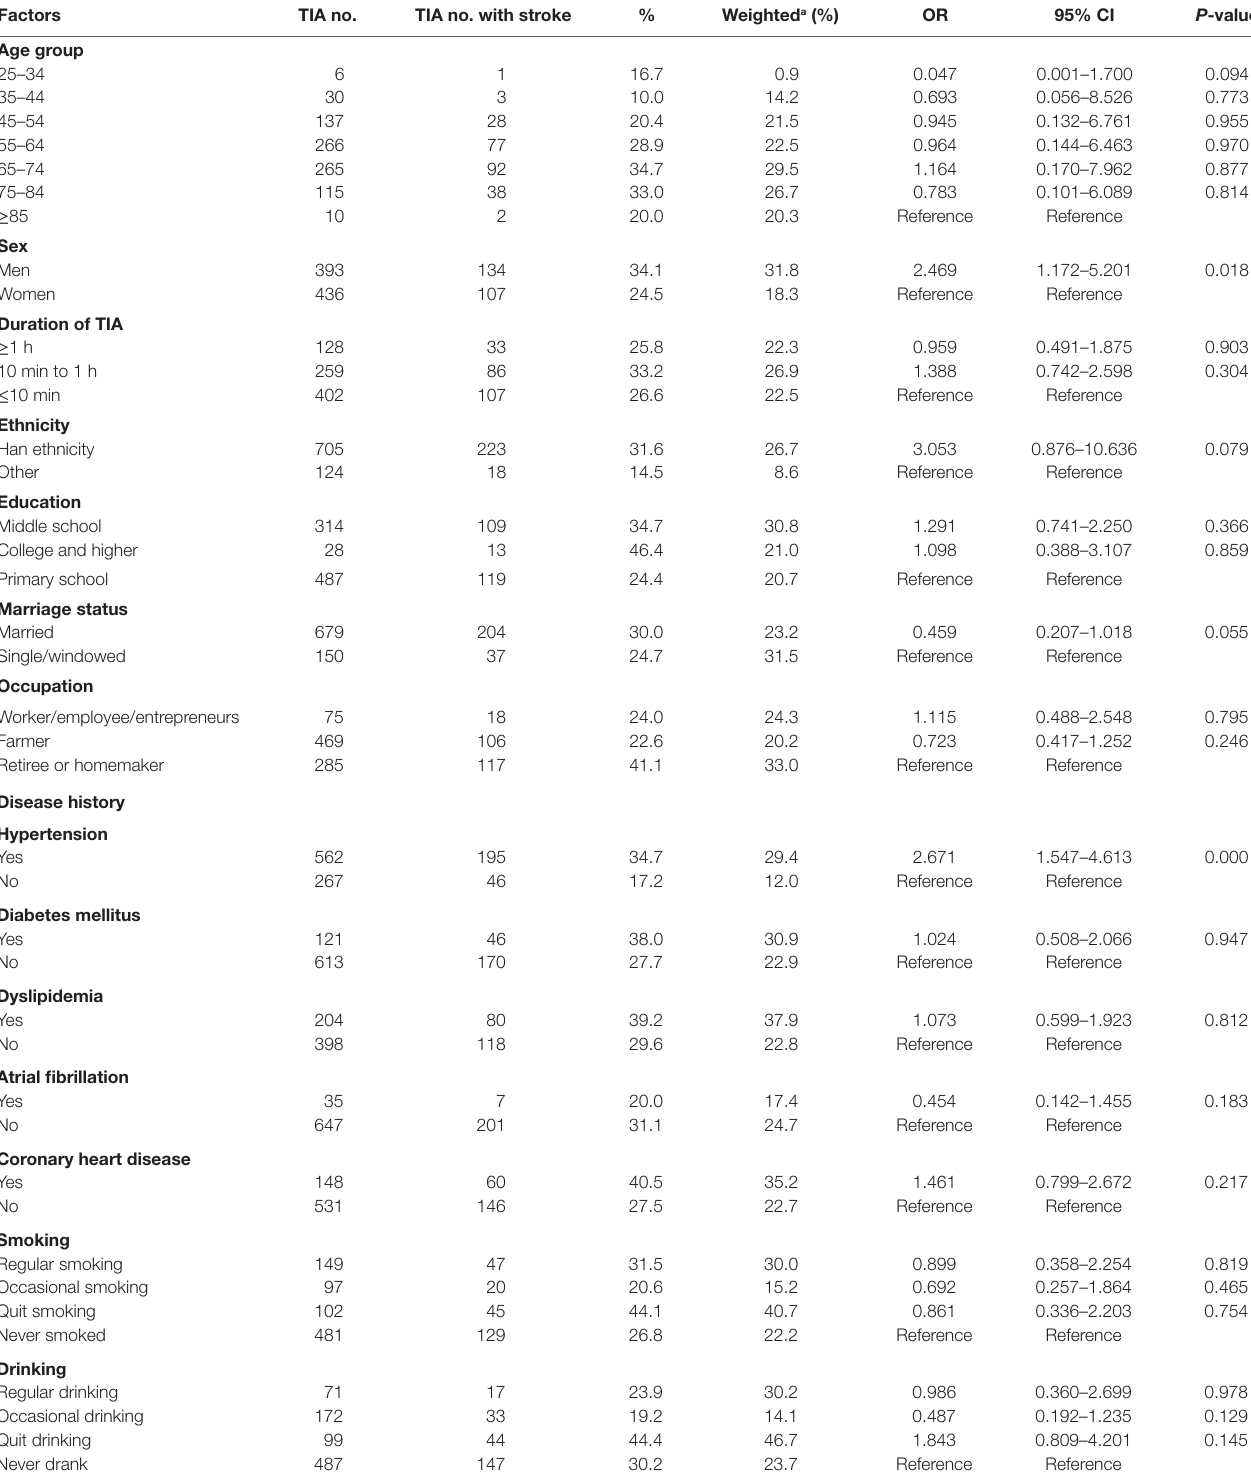
Table 4 | Stroke-associated prognostic factors of transient ischemic attack (TIA) in China, 2013. Factors Tia no. Tia no. with